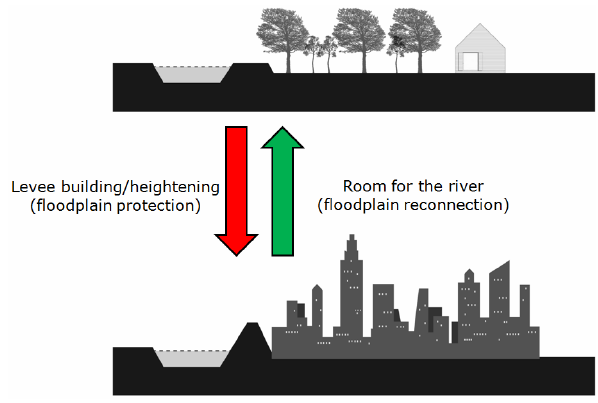
Figure 2. Floodplains as fully coupled human-water systems: shifts in floodplain management between "living with floods" [top panel] and "fighting floods" [bottom panel].